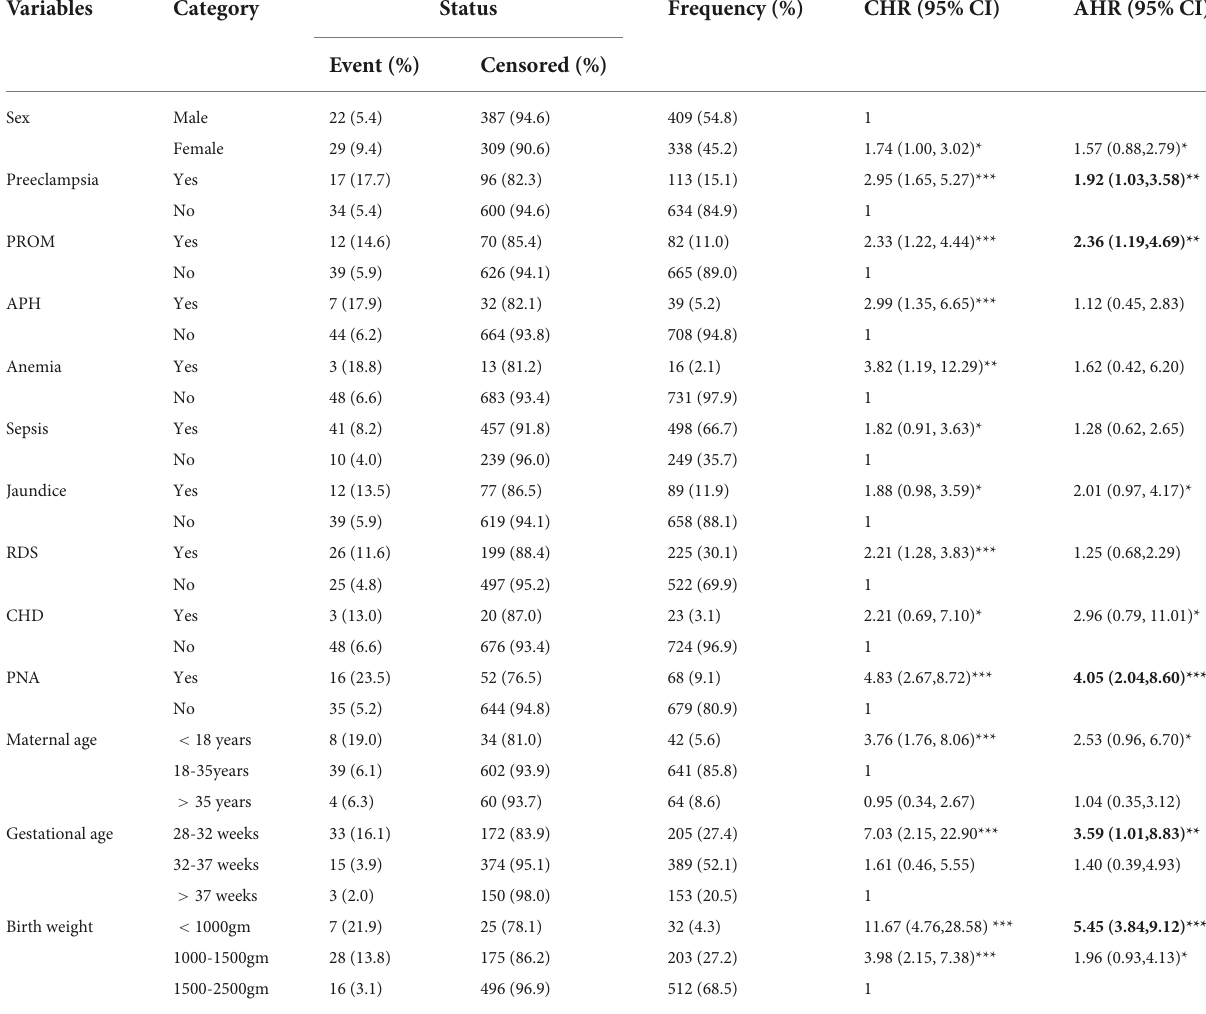
TABLE 4 The bivariate and multivariate Cox proportional hazard regression output among LBW neonates admitted to the NICU of FHCSH, Ethiopia from 1 January 2015 to 30 December